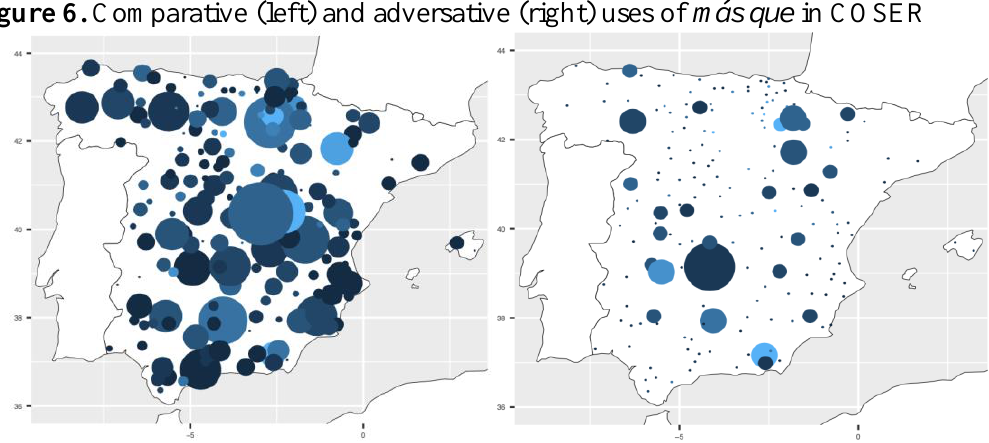
Figure 6. Comparative (left) and adversative (right) uses of más que in